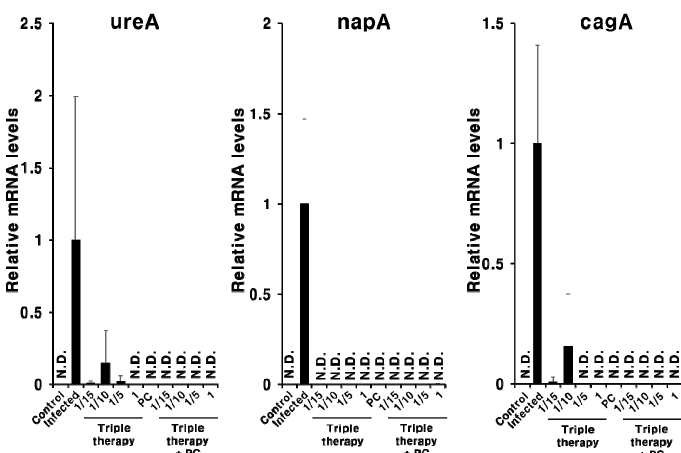
Figure 7. Expression of H. pylori ureA, napA, and cagA mRNA in the gastric tissue of the H. pylori -infected mice following combination treatment with PC and triple therapy. Different letters indicate a significant difference ( p < 0.05), ascertained via the Tukey–Kramer test. Triple therapy was administered at four concentrations. 1, Existing concentration of triple therapy (metronidazole and clarithromycin: 16.7 mg/kg; omeprazole: 700 μ g/kg); 1/5, one-fifth of the existing concentration of triple therapy; 1/10, one-tenth of the existing concentration of triple therapy; 1/15, one-fifteenth of the existing concentration of triple therapy. PC was administered at 1 mg/kg. N.D., not detected.